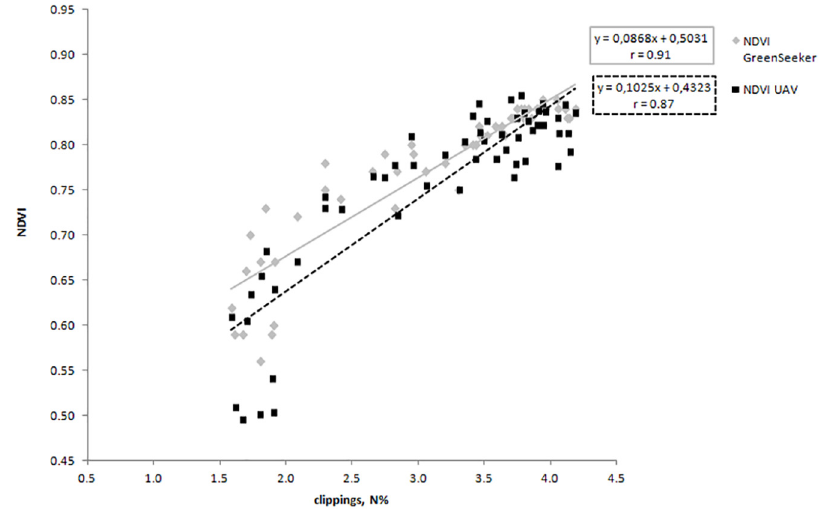
Fig 5. Relationships between the clippings nitrogen content of Paspalum vaginatum and NDVI data obtained with a ground-based spectral reflectance instrument (Trimble ’ s GreenSeeker sensor) and an unmanned aerial vehicle (UAV). Values represented the 4